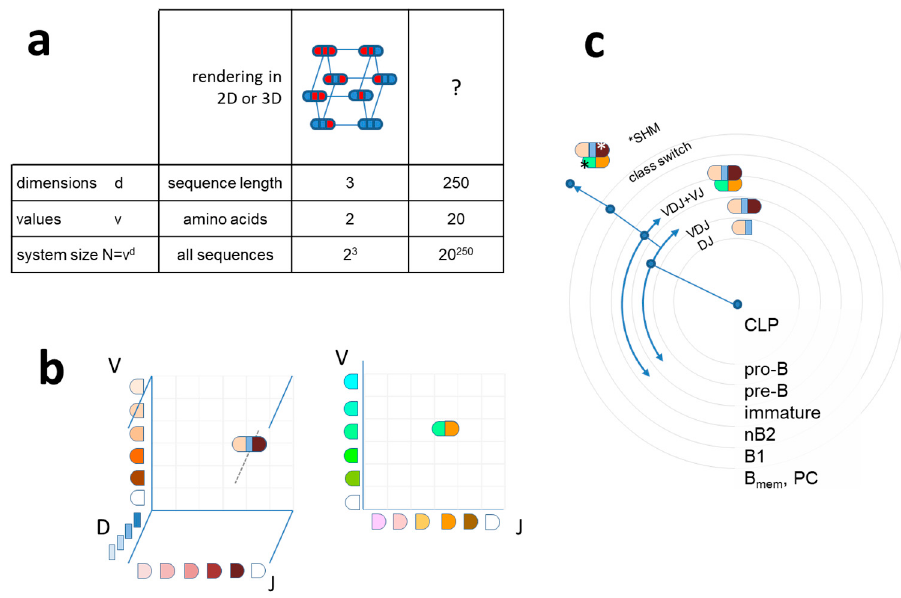
Figure 1. Sequence space and visualization of antibody sequence relationships ( a ) Theoretical diversity (system size N) of a sequence is determined by its length (dimension) and the number of values a particular position in the sequence can take. An antibody Fv region of 250 amino acids has an astronomical sequence diversity if full randomization is allowed. ( b ) Antibody sequences are frequently interpreted as recombined germline sequences. Such display of combinatorial diversity may allow the tracking of specific clonal expansions and further diversification by somatic hypermutation (SHM). ( c ) The potential development scheme of a given antibody clone is shown with antibody sequence development along with B-cell differentiation steps. Arching arrows represent combinatorial diversification by V–D–J rearrangement and light chain paring. CLP, common lymphoid progenitor; nB2, naïve B2 cell; Bmem, memory B cell; PC, plasma cell.